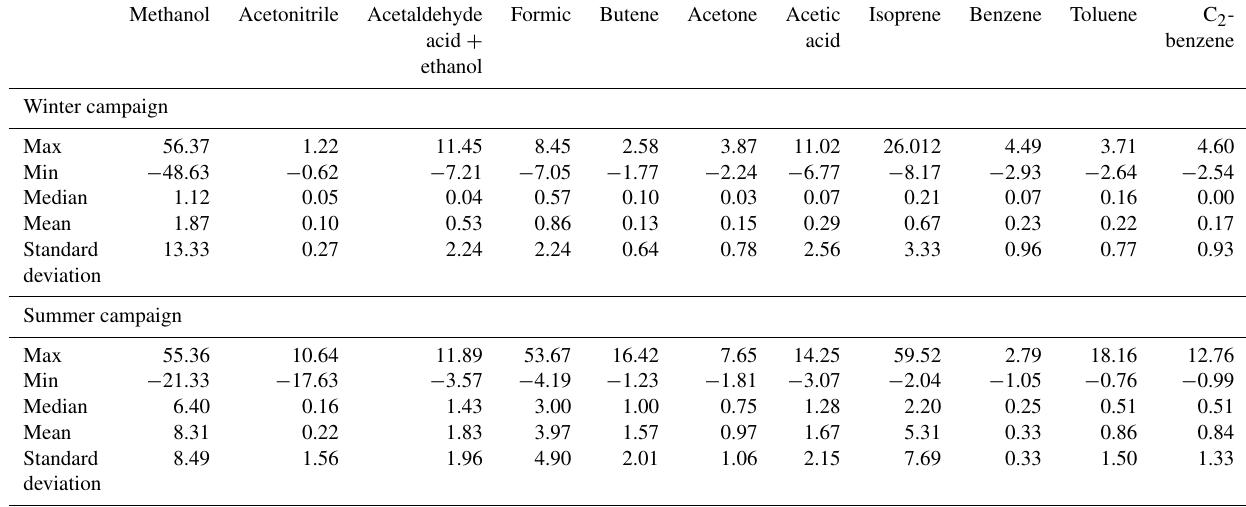
Table 2. Summary of stationarity filtered fluxes (including the storage term) of VOCs displayed in Table 1, including the six dominant VOC fluxes recorded in Beijing during the APHH-Beijing winter and summer campaigns (in nmolm − 2 s − 1 ). Methanol